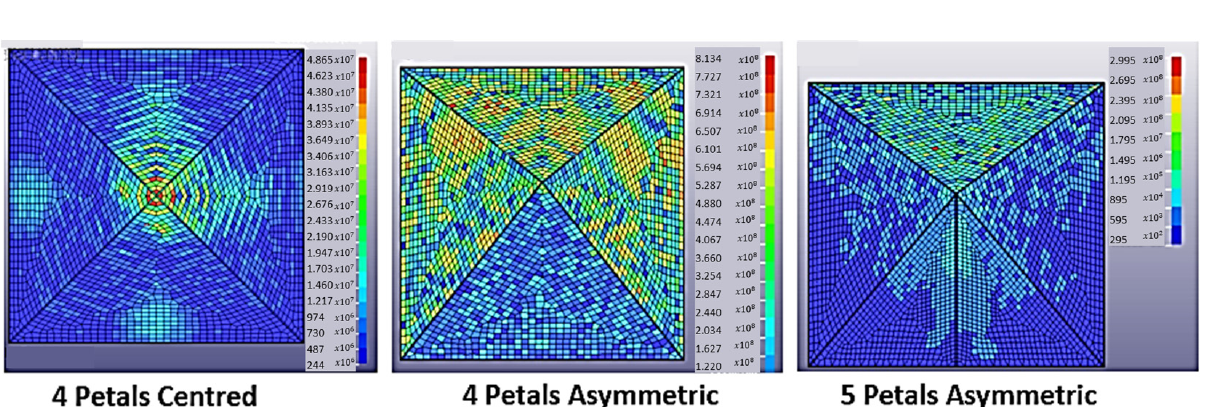
Figure 11. Planar tailgates: Stress Distribution.